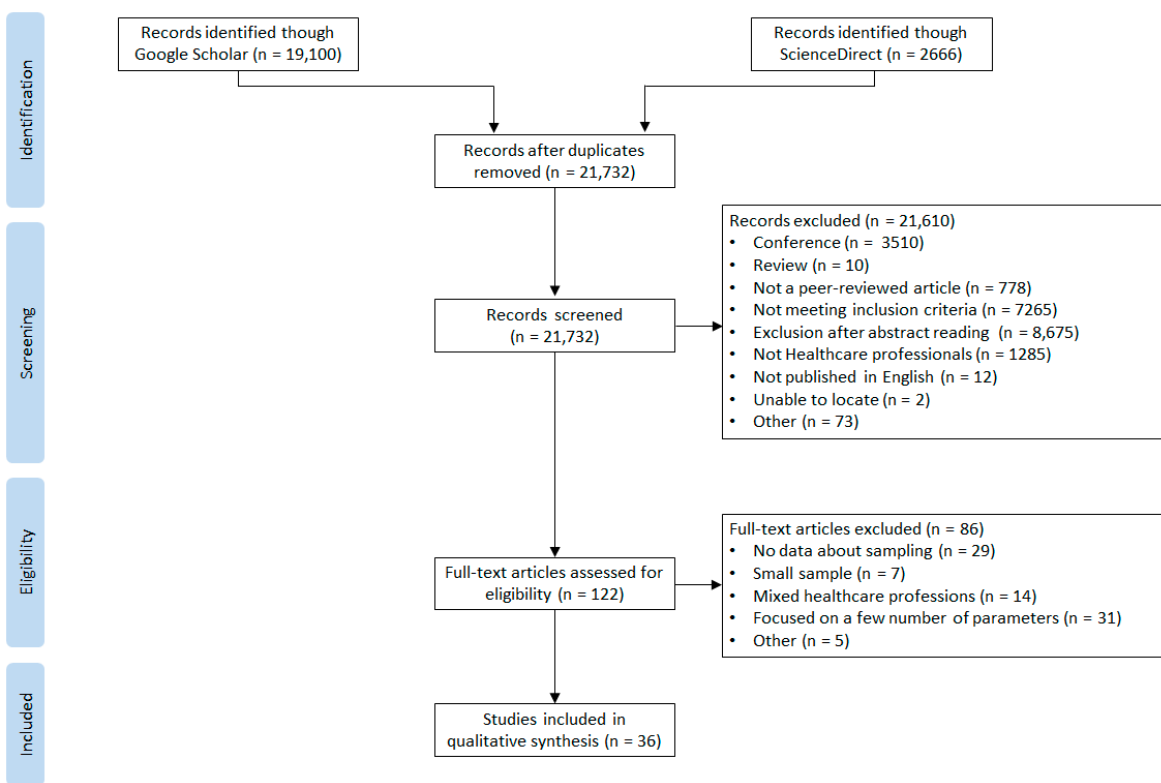
Figure 1. PRISMA Flow Chart.